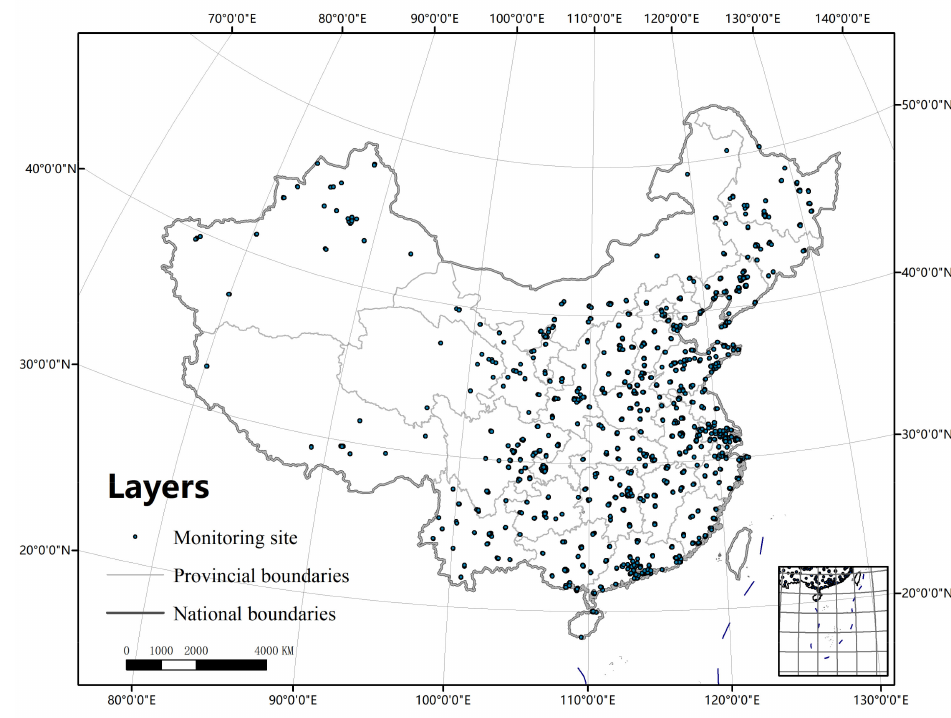
Figure 2. Distribution of meteorological